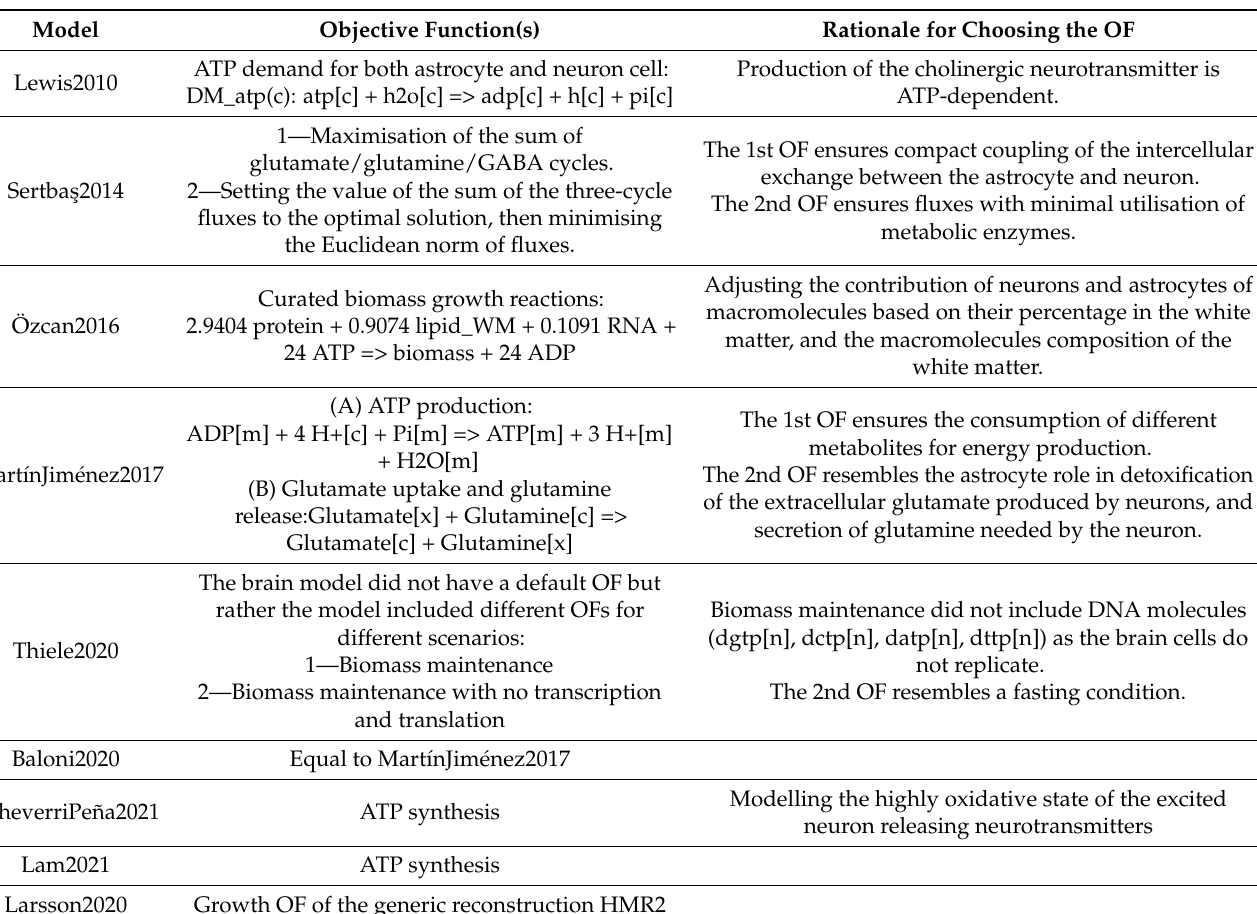
Table 3. Objective functions used in the brain-specific models and the rationales for using